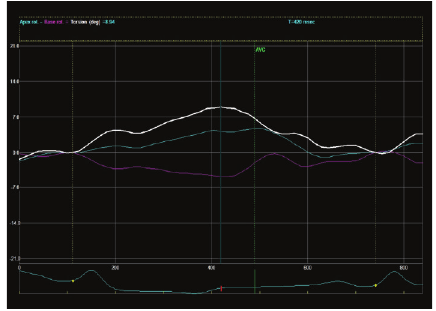
Figure 1: A representative case of left ventricular (LV) twist (8.94 ∘ ) in sinus rhythm. The white color tracing denotes LV twist; blue denotes apical rotation (4.75 ∘ ); purple denotes basal rotation. AVC: aortic valve